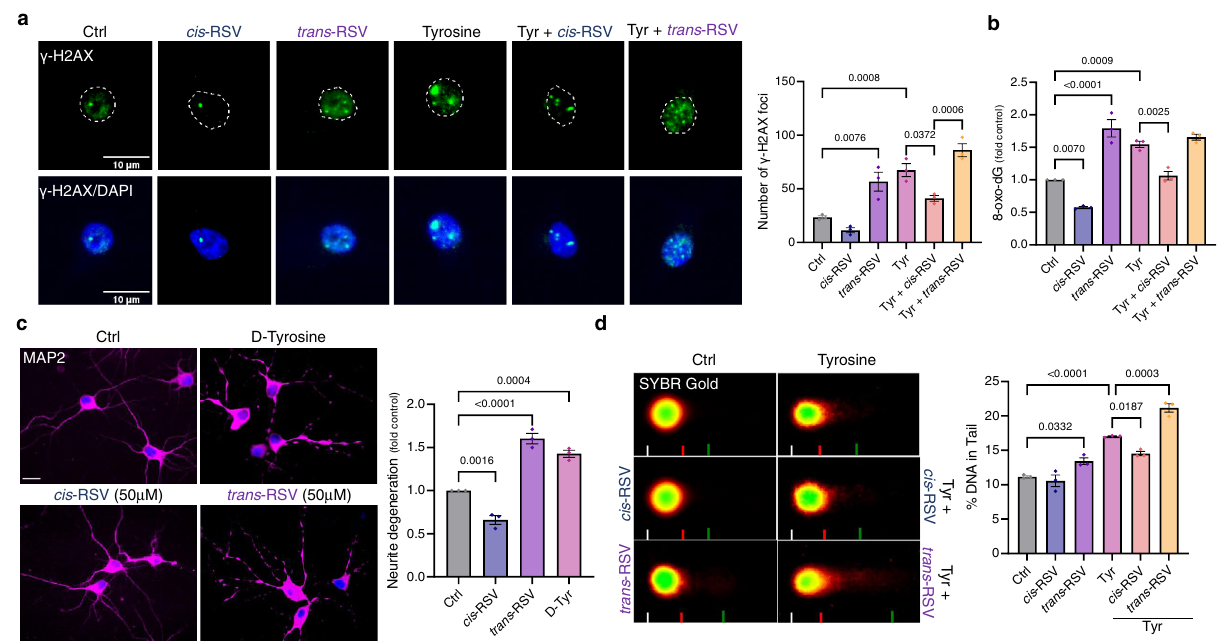
Fig. 4 Tyrosine induces oxidative DNA damage in neurons, and cis -RSV protects neurons against it. a Cis-RSV and trans-RSV have opposite effects on tyrosine-mediated accumulation of γ -H2AX . Immunostaining images (scale bar, 10 µ m) for DNA damage marker, pSer139-H2AX foci ( γ -H2AX, green; DAPI – nuclear marker, blue) in cortical neurons (DIV 10) after treatment with cis - and trans -RSV (50 µ M) alone or in combination with L-tyrosine (250 μ M) for 24 hr. The graph represents the average number of γ -H2AX foci per n = 30 neurons per treatment condition for n = 3 experiments. b cis- and trans-RSV have opposite effects on tyrosine-mediated induction of the oxidative damage in the neuronal DNA . Quanti fi cation of the levels of 8-oxo-2 ′ -dG using immuno fl uorescence (IF) in rat primary cortical neurons (DIV 9/10) after treatment with L-tyrosine (500 μ M) either alone or in combination with cis or trans -RSV (50 μ M) for 16 hr for n = 3 experiments. c D-tyrosine and trans-RSV induce neurite degeneration . Representative images (scale bar, 20 µ m) for cortical neurons following D-tyrosine or cis -RSV and trans -RSV (50 µ M) for 24 hr treatment (MAP2 – neurite marker, magenta and DAPI – nuclear marker, blue). Neurons were immunoassayed with anti-MAP2 antibody and quanti fi ed for neurite degeneration. d Comet assay measuring the extent of DNA strand breaks induced by tyrosine and trans-RSV . Cortical neurons (DIV 9/10) were treated with cis -RSV (50 µ M), trans -RSV (50 µ M), L-tyrosine (1 mM) either alone or in combination for 1 hr, and the percentage of DNA in the comet tails was quanti fi ed as described in the Methods. All data represent mean ± SEM for n = 3 independent experiments with signi fi cance measured using two-way ANOVA with Tukey ’ s test for multiple